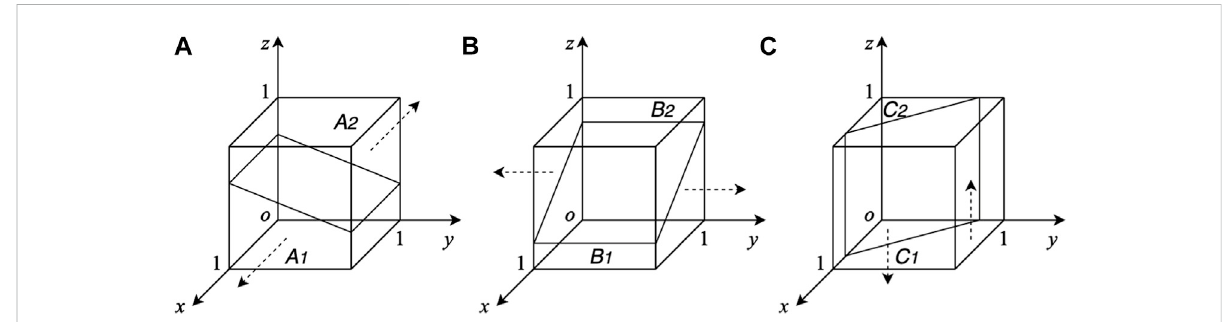
FIGURE 1 (A) The phase diagram of government strategy evolution. (B) The phase diagram of the strategic evolution of the enterprise. (C) Resident strategy evolution phase